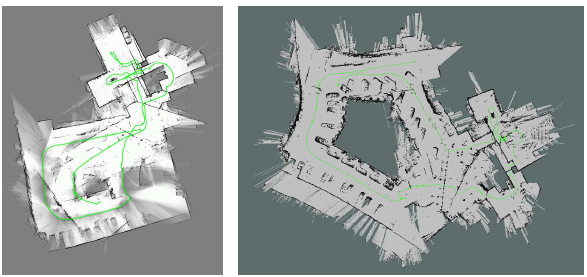
Figure 2: Left: Cartographer. Right: